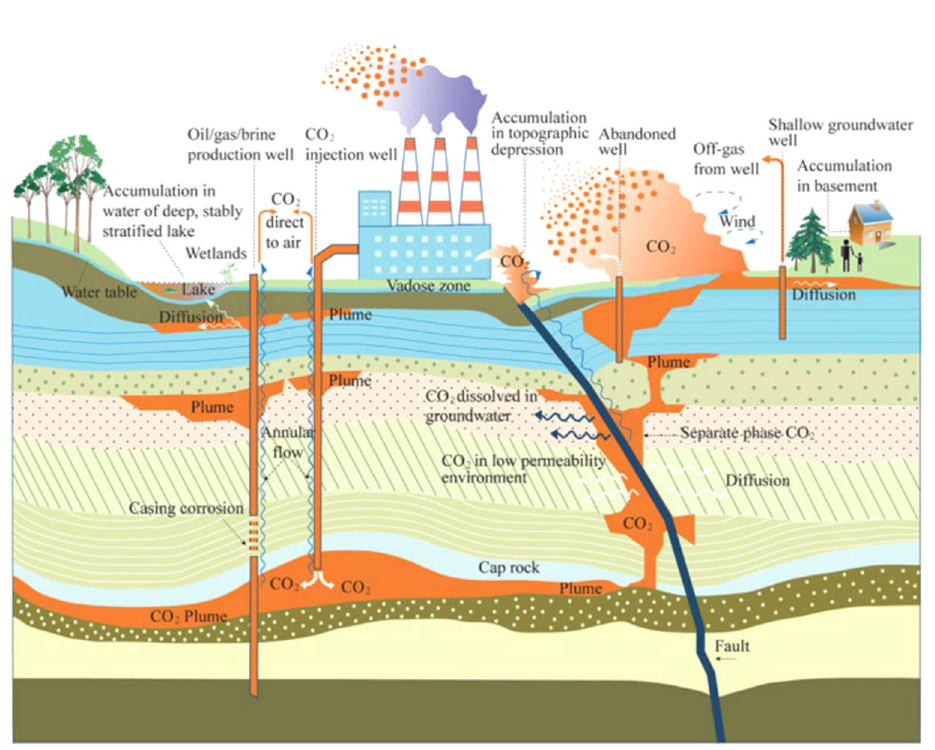
Fig. 16. – Possible leakage pathways of sequestered CO 2